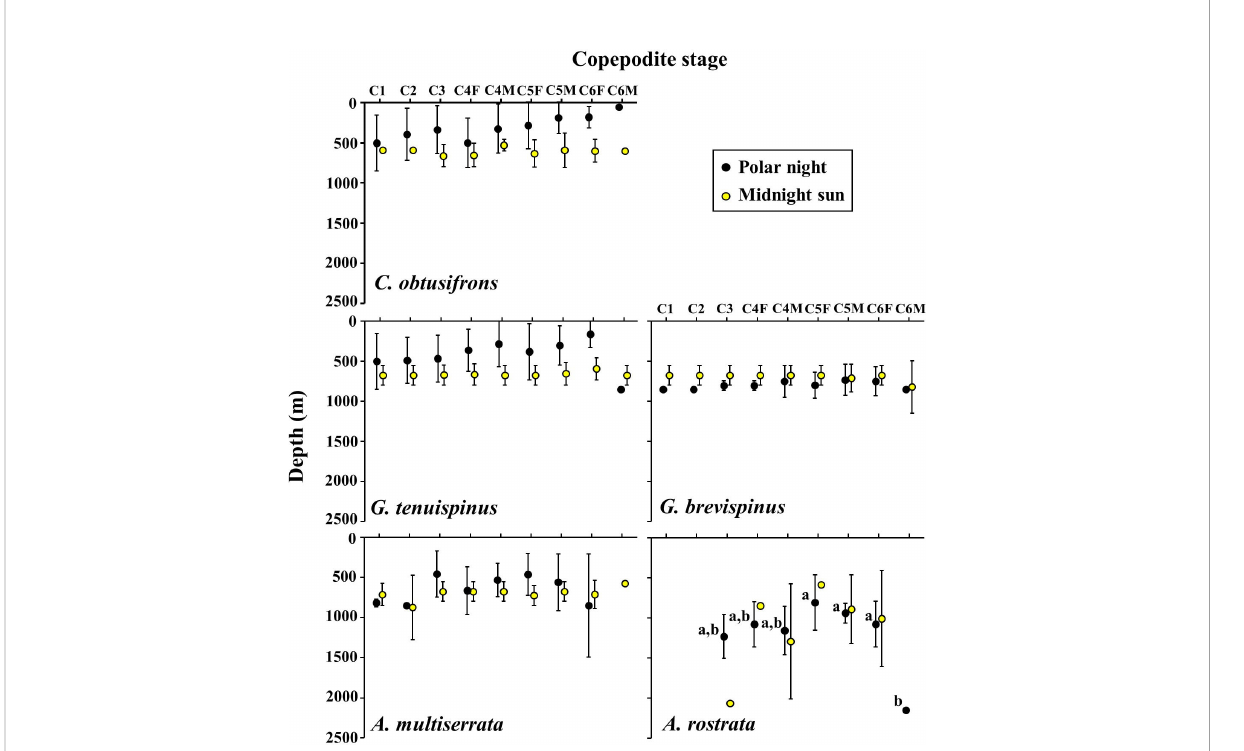
FIGURE 5 Ontogenetic changes in vertical distribution of the copepodite stages of the fi ve Aetideidae copepods dominant in the western Arctic Ocean during the polar night and midnight sun. Symbols and bars represent means of the distribution centres ( D 50% ) and their standard deviations, respectively. F, female; M, male. The species are: Chiridius obtusifrons , Gaetanus tenuispinus , G. brevispinus , Aetideopsis multiserrata , and A. rostrata. Alphabet letters for A. rostrata during the polar night indicate signi fi cant differences between stages.